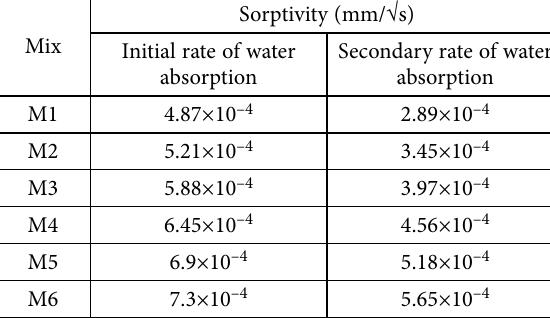
Table 5. Sorptivity of lightweight concrete mixes